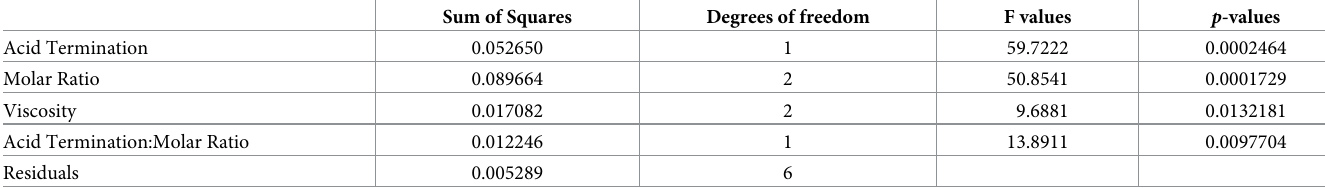
Table 4. ANOVA table with F test. Only the factors with significant effects over the response (mass loss) are shown.